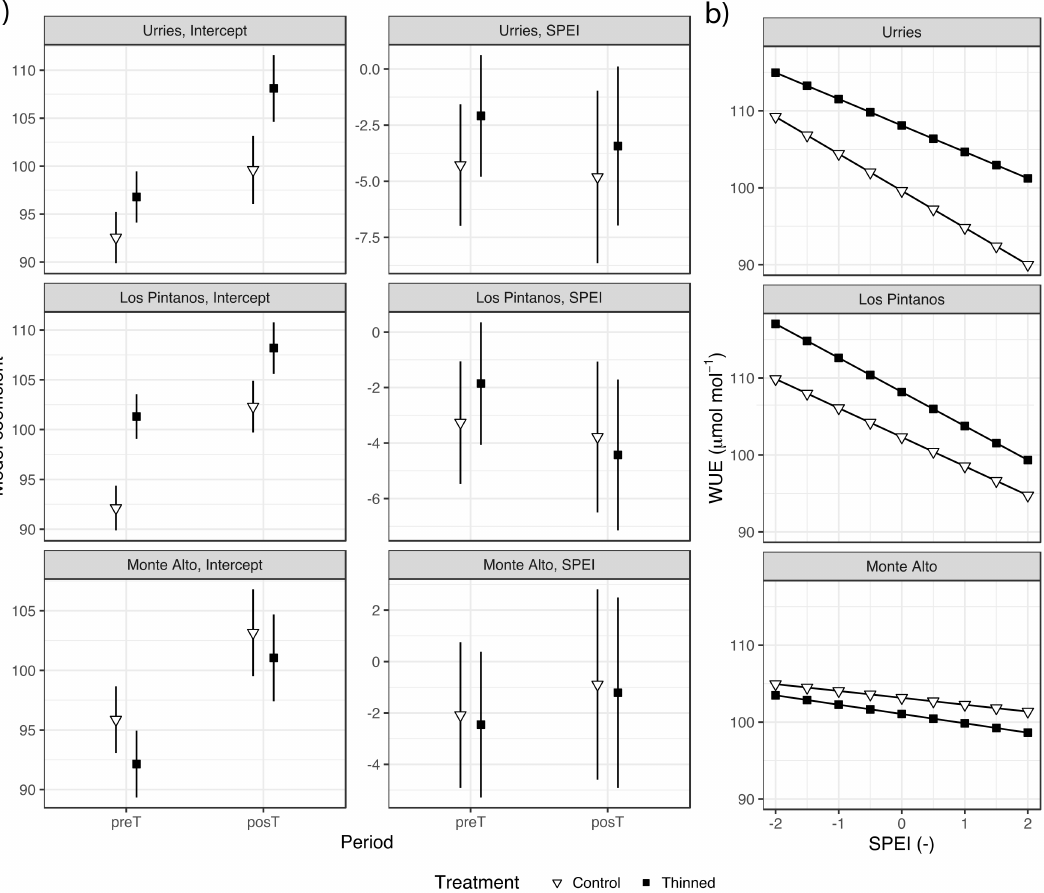
Figure 5. Intrinsic water use efficiency (WUEi), mean values model coefficients for the fixed effects (bars depict 95% confidence intervals) in Urri é s, Los Pintanos and Monte Alto sites, for control and thinning treatments during pre- ( preT ) and post-thinning ( posT ) periods ( a ), and generalised linear models of WUEi against SPEI for the two treatments in the posT period ( b